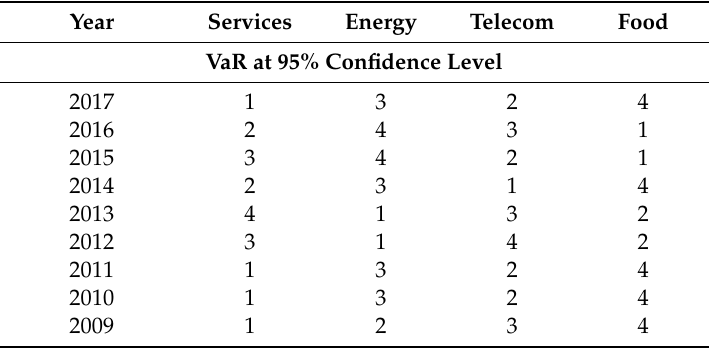
Table 4. Ranking of four targeted industries by year,